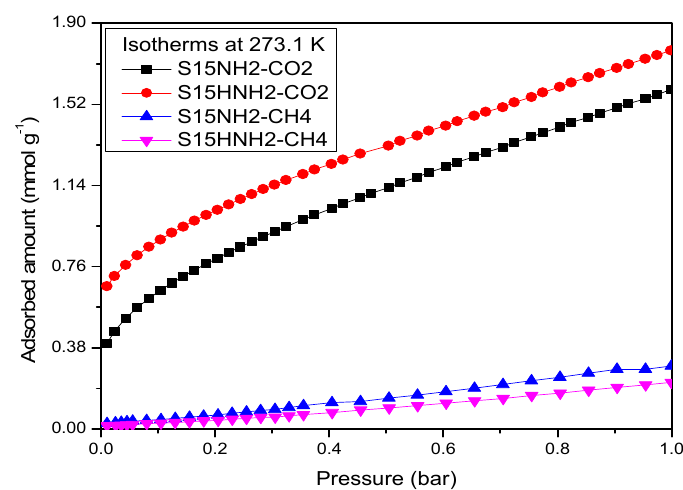
Figure 16. CO 2 and CH 4 adsorption isotherms at 273 K on APTES functionalized materials SBA-15 (pristine S15) and hydroxylated silica S15H. Materials 2016 , 9 , 898